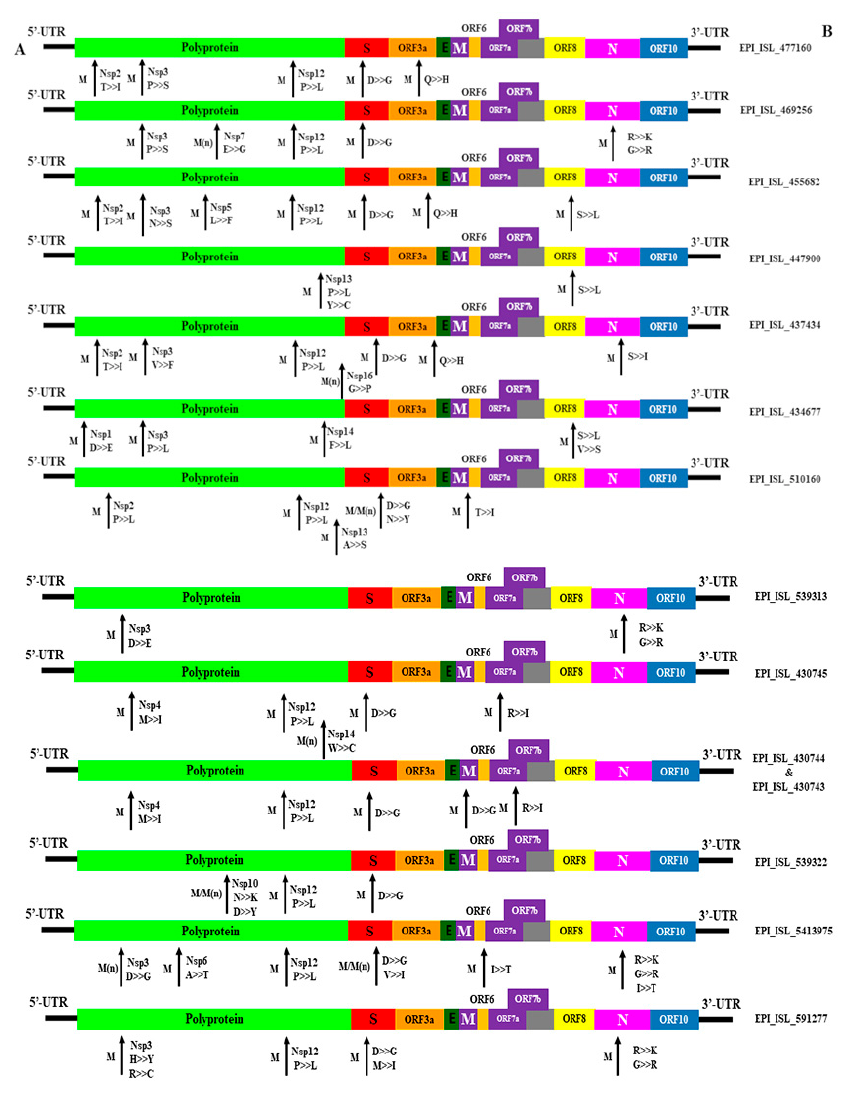
Figure 7. Genomic mutation analysis of environmental-originated SARS-CoV-2. >> and marking indicating the mutational changes among 12 SARS-CoV-2 (EPI_ISL_408514 is not included due to Nil mutation) strain studied in this study in comparison with the reference strain NC_045512.2, hCoV19/Wuhan/WIV04/2019. Here, M—mutation;